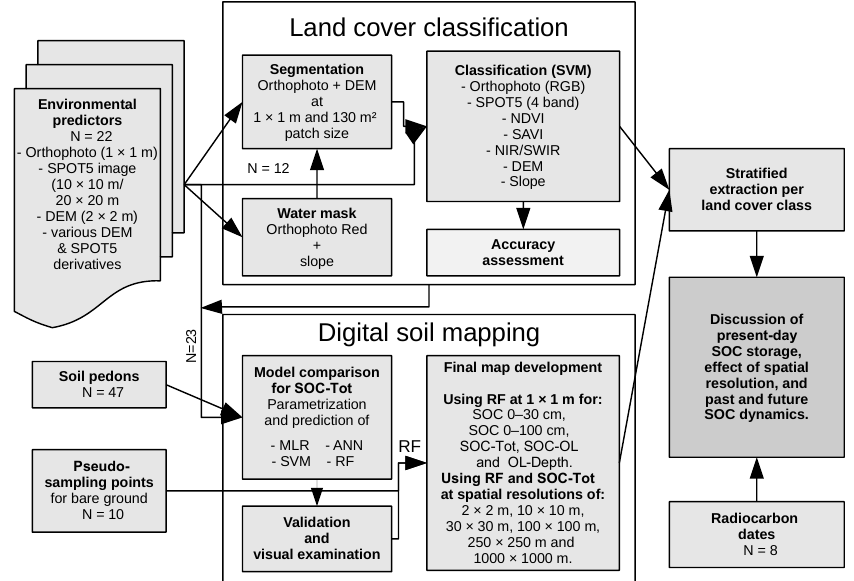
Figure 3. Workflow diagram for this study. Environmental predictor variables are used to generate a land cover classification. Digital soil mapping is performed using soil pedons combined with environmental predictor variables to train prediction models for total SOC (SOC– Tot). The best performing model (RF) is used to develop maps of different SOC depth increments and the OL depth (supplemented with pseudo-sampling points). The results are discussed, with the help of eight radiocarbon samples, in the context of present-day SOC storage, the effect of spatial resolution, past and future SOC dynamics, and the relevance of wetlands for the SOC storage in permafrost